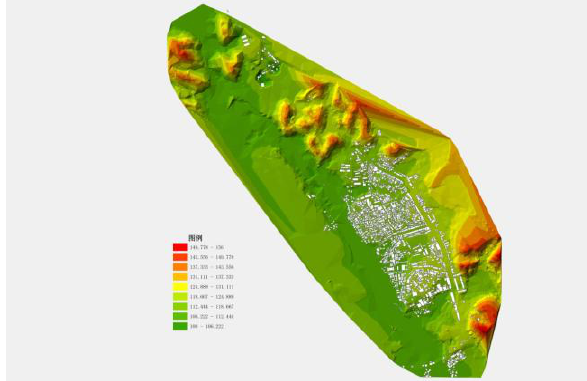
Figure 3. The elevation analysis for the settlement layout